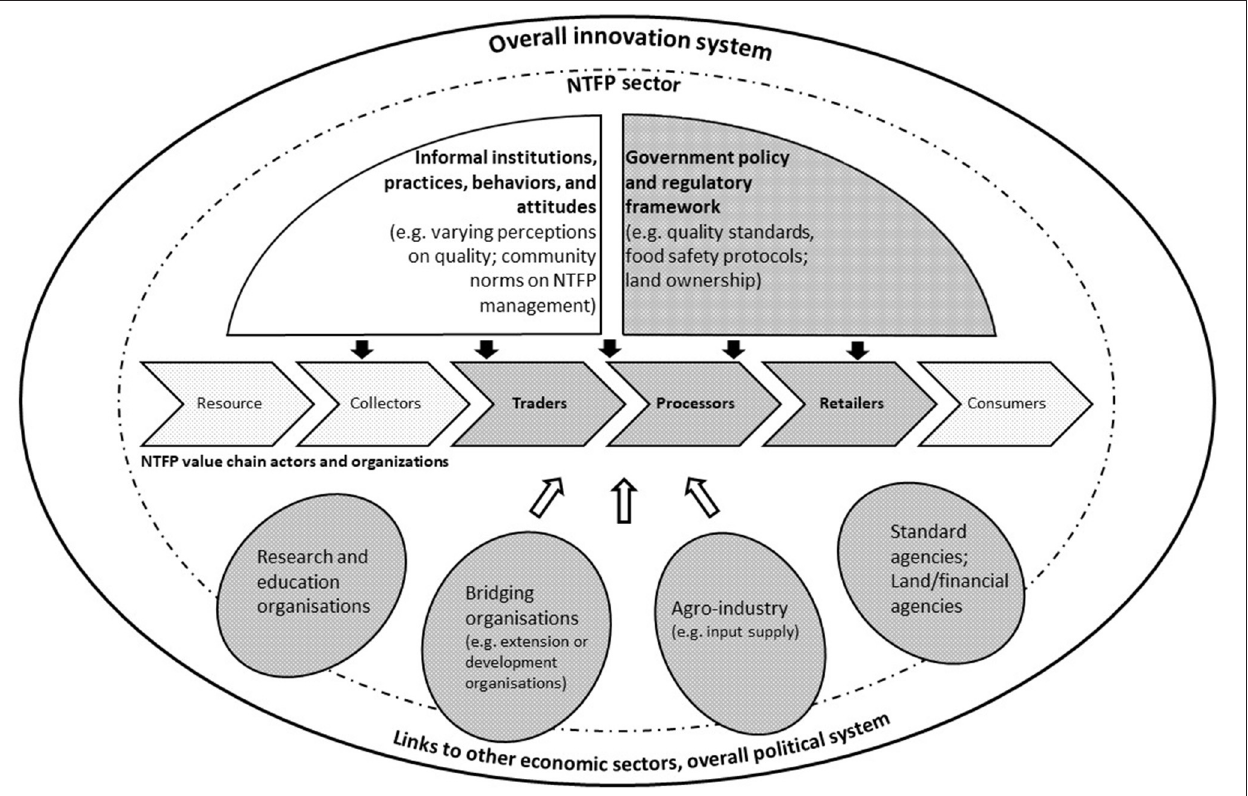
FIGURE 1 | Overall conceptual framework. Transitioning from NTFP subsistence to commercial use, further actors and institutions gain importance (highlighted in darker shade).